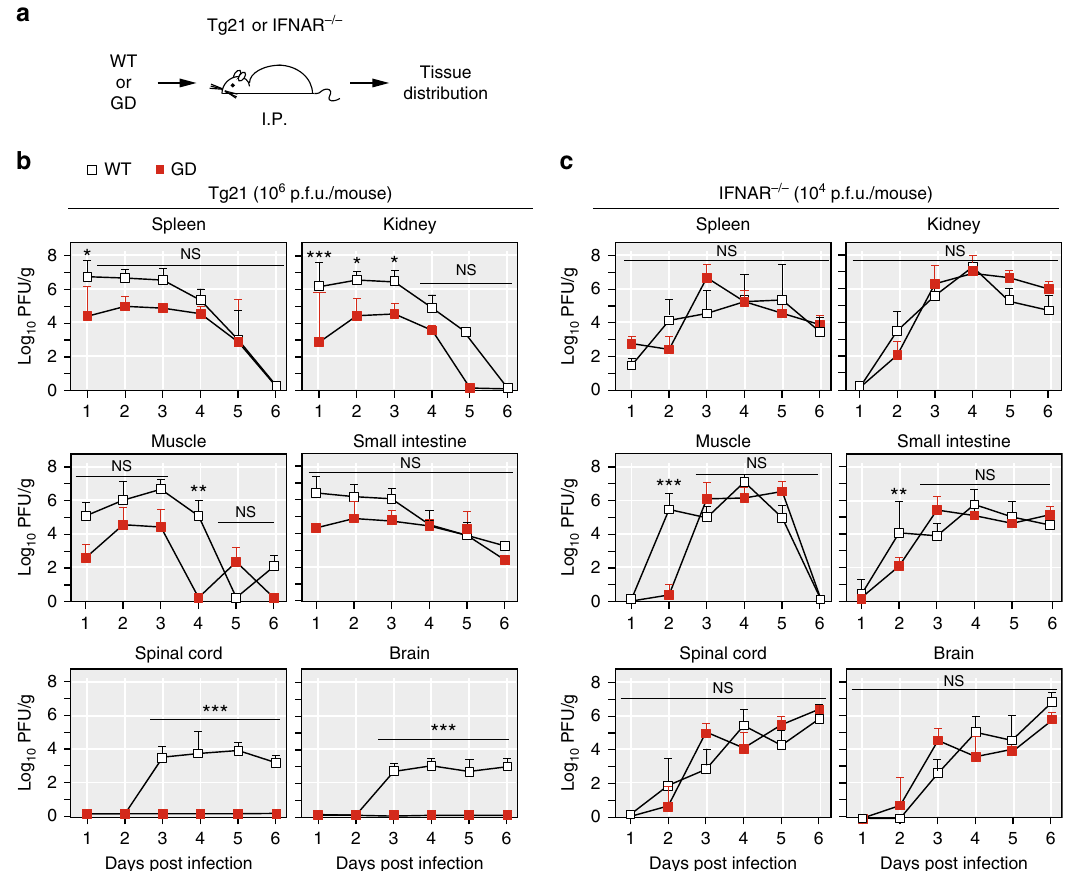
Fig. 2 The tissue distribution of the virus strains in Tg21 and IFNAR − / − mice. a Experimental schematic for determining the virus titer in individual tissues. b , c Virus titers in tissue collected from WT or GD infected mice by I.P. inoculation route. Tg21 (10 6 PFU per mouse) or IFNAR − / − (10 4 PFU per mouse). Data are shown as logarithm, mean ± s.d., PFU per gram of tissue ( n = 5, the number of mice is fi ve for each time point and each group). Student ’ s t